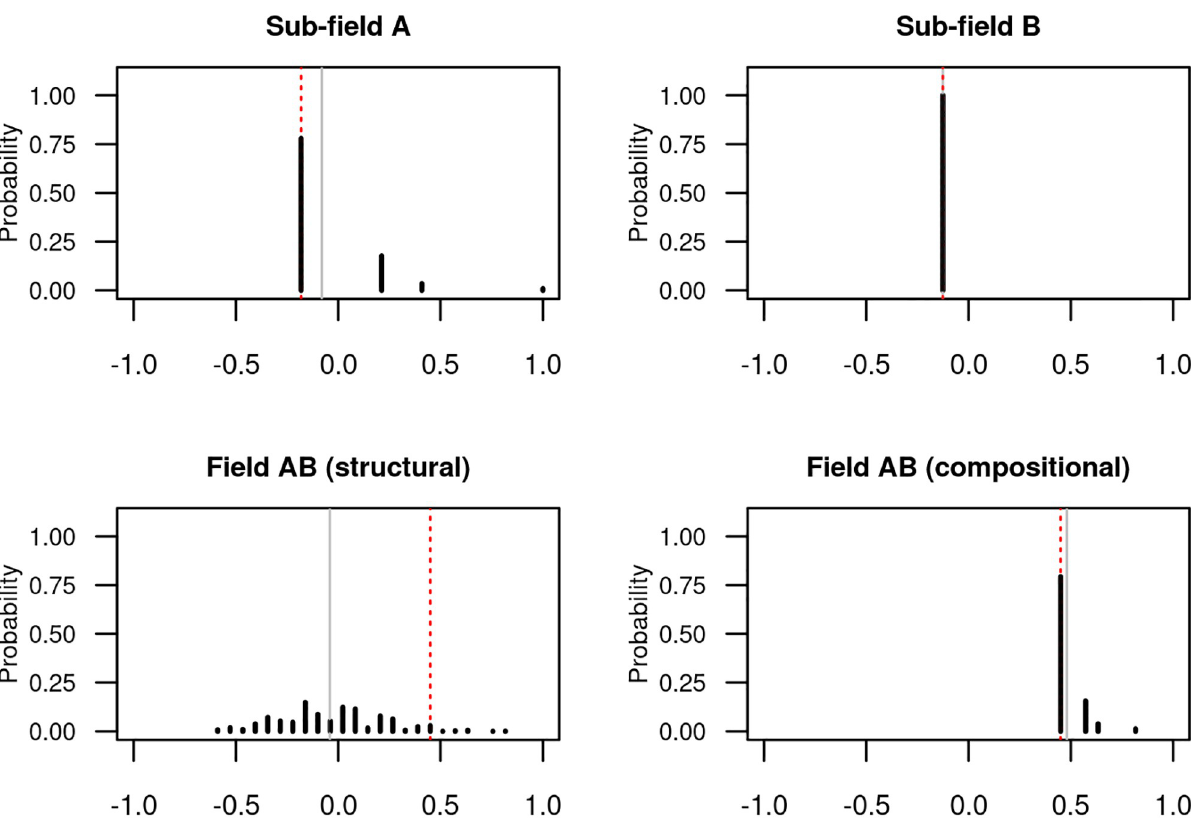
Fig 2. Structural and compositional homophily example. The plot shows the distribution for the index of assortativity, α when the authorships are generated according to several processes. The top panels show the distribution of α which reflects the structural homophily for sub-fields A and B; i.e., authorships are randomly permuted to different documents. The bottom left panel shows the distribution of α for the field AB which only reflects structural homophily (i.e., all authorships in the field are randomly permuted) and the bottom right panel shows the distribution of the field which reflects both structural and compositional homophily (i.e., authorships are randomly permuted within their sub-field). In each plot, the dotted red line indicates the observed value of α and the solid gray line indicates the mean value under the null distribution. Note that under the null distribution which only reflects structural homophily, the observed α is larger than the mean α . However, in the null distribution which accounts for compositional homophily, the mean α is larger than the observed α .